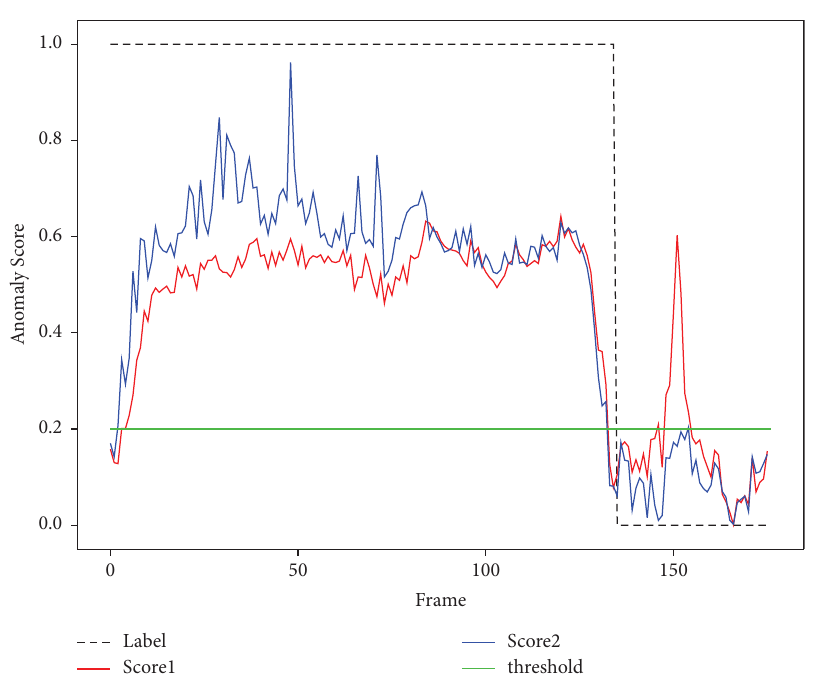
Figure 7: Anomaly scores on the Ped1 testing set.